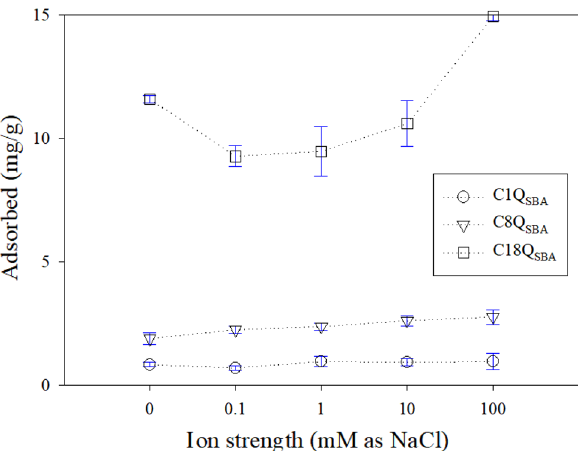
Figure 5. Effect of ionic strength on CBZ adsorption by Q SBA